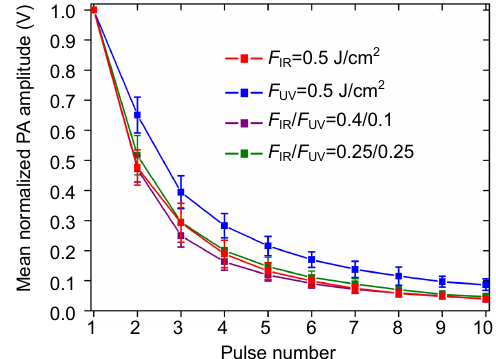
Fig. 7 | Mean normalized PA signal for 10 incident laser pulses of: F IR = 0.5 J/cm 2 (red), F UV = 0.5 J/cm 2 (blue), simultaneous F IR = 0.4 J/cm 2 and F UV = 0.1 J/cm 2 (purple), simultaneous F IR = F UV = 0.25 J/cm 2 (green).